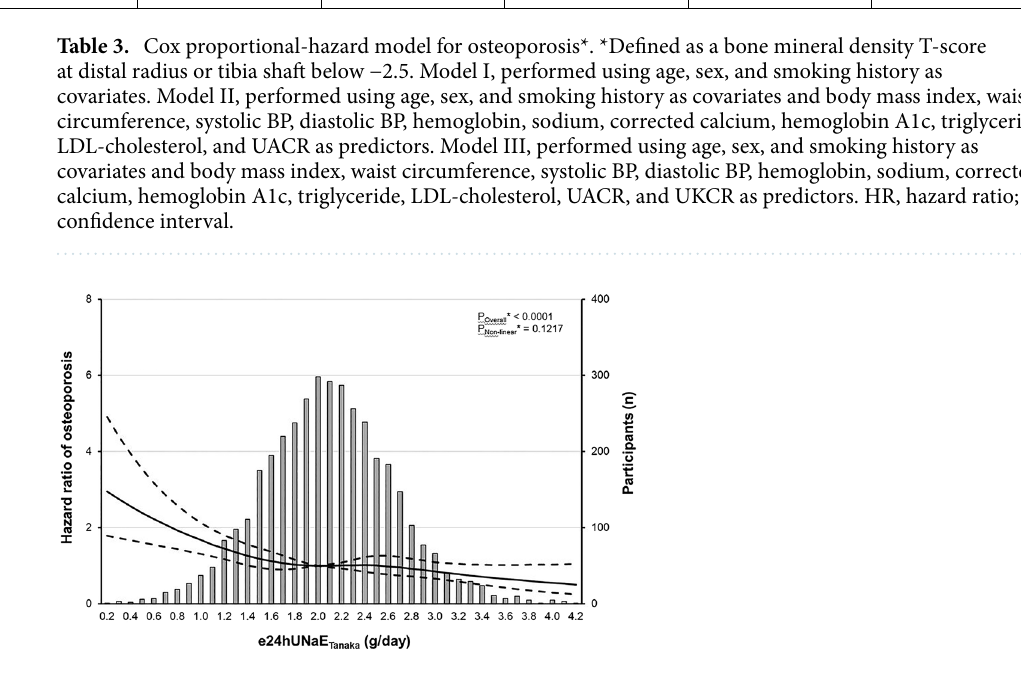
Figure 2. Relationship between dietary salt intake and hazard ratio of osteoporosis*. Solid line represents the adjusted HR** of incipient osteoporosis and dash lines 95% CIs**. *Defined as a bone mineral density T-score at either distal radius or tibia shaft below −2.5. **Calculated by restricted cubic spline Cox-proportional hazard regression model using age, sex, and smoking history as covariates and body mass index, waist circumference, systolic BP, diastolic BP, hemoglobin, sodium, corrected calcium, hemoglobin A1c, eGFR, triglyceride, LDL- cholesterol, UACR, and urine potassium/creatinine ratio as predictors. e24hUNaE Tanaka , Tanaka method for estimating 24-h urinary sodium excretion.